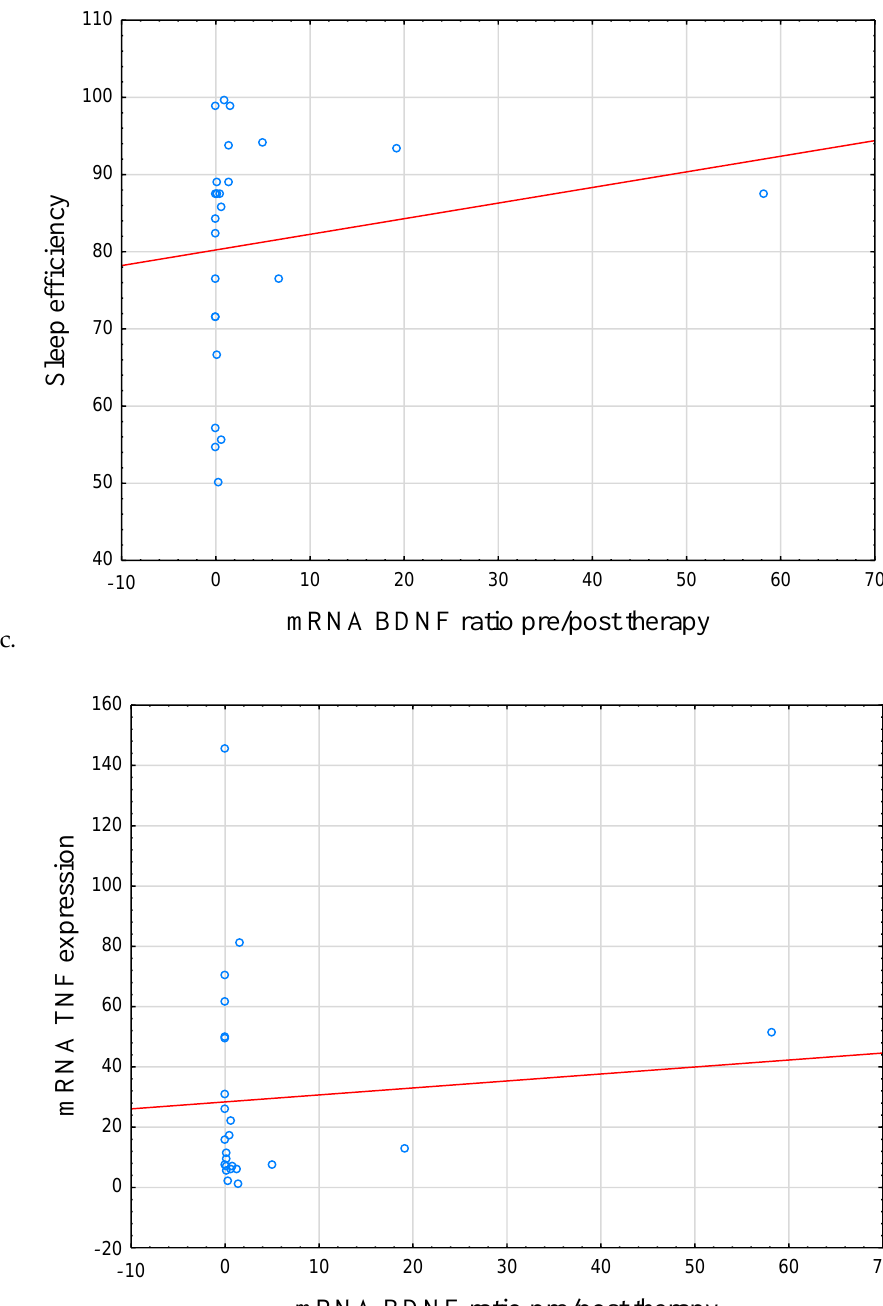
Figure 5. Correlation between symptoms of insomnia, poor sleep quality, sleep efficiency, mRNA TNF, and BDNF mRNA ratio pre/post therapy. ( a ) Correlation between AIS score and BDNF mRNA ratio pre/post therapy. ( b ) Correlation between PSQI score and BDNF mRNA ratio pre/post therapy. ( c ) Correlation between sleep efficiency and BDNF mRNA ratio pre/post therapy. ( d ) Correlation between TNF mRNA and BDNF mRNA ratio pre/post therapy. mRNA BDNF ratio pre/post therapy was negatively correlated with the severity of insomnia symptoms (AIS score) at the baseline (r = −0.409, p = 0.042) as well as poor sleep quality (r = −0.441, p = 0.027). A positive correlation was observed between the mentioned parameter and sleep efficiency (r = 0.439, p = 0.028). mRNA BDNF and mRNA TNF ratios pre/post therapy were also negatively correlated (r = −0.572, p = 0.004). Abbreviations: AIS—Athens Insomnia Scale, BDNF—Brain-Derived Neurotrophic Factor, TNF—Tumor Necrosis Factor, PSQI—Pittsburgh Sleep Quality Index.